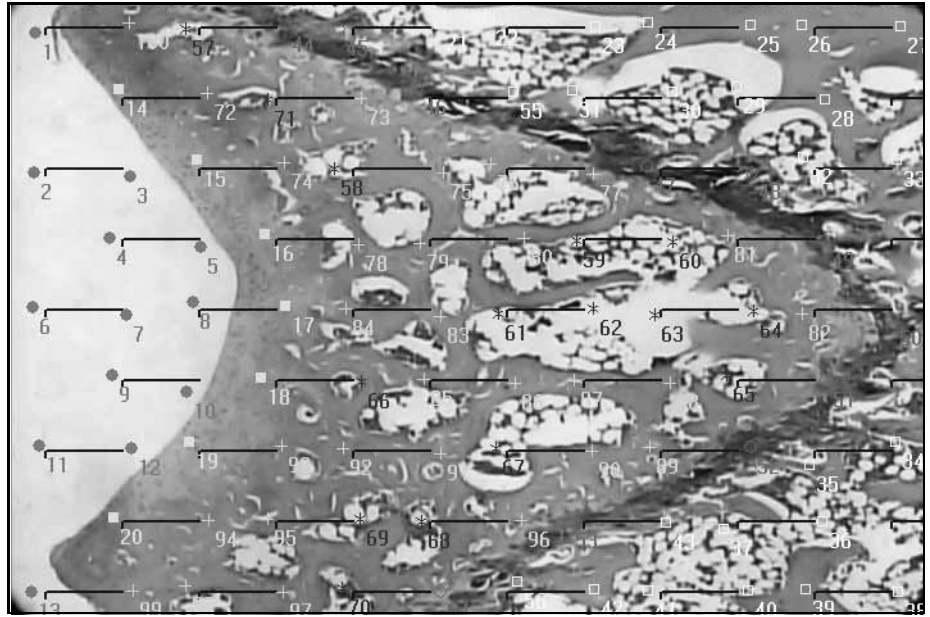
Figura 4 – Côndilo femoral e gratículo para contagem de 100 pontos na imagem digitalizada sob aumento final de 20× mostrando marcação e contagem dos componentes epifisários por área